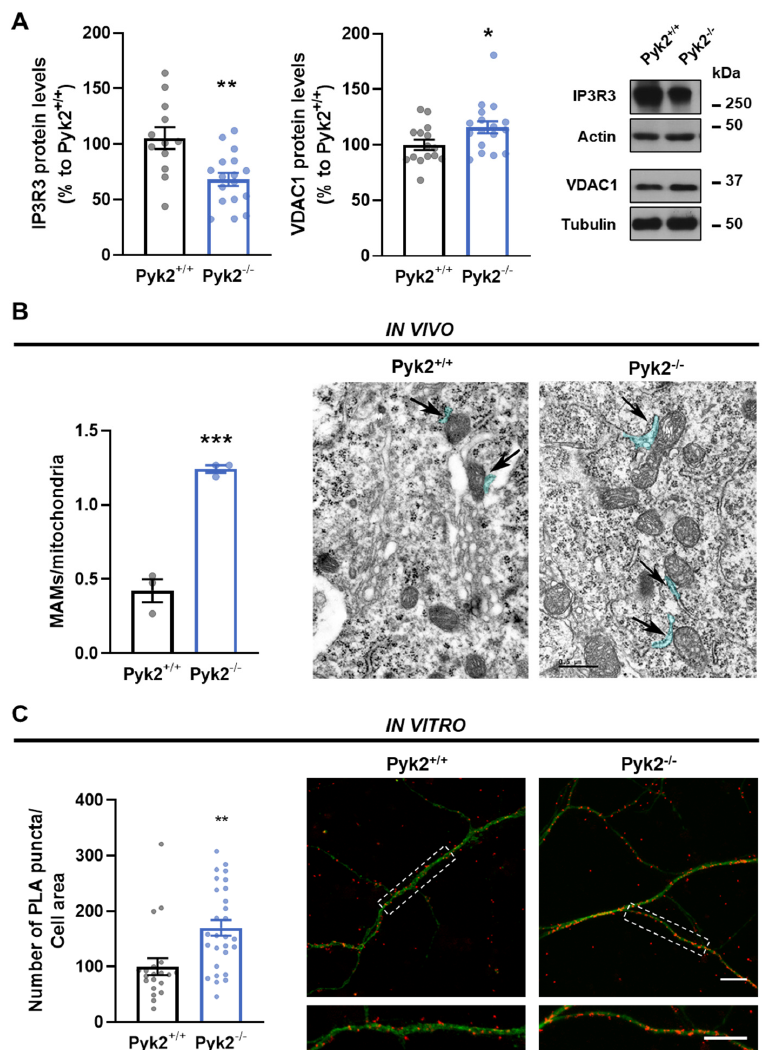
Figure 3. Pyk2 ablation induces increased number of ER–mitochondria contact sites in vivo and in vitro . ( A ) Densitometry quantification and representative immunoblotting of IP3R3 (Student t -test, t = 3.457, df = 27; * p < 0.05) and VDAC1 (Mann–Whitney test, A, B = 189, 339, U = 69; * p < 0.05) in total lysates of hippocampus from Pyk2 +/+ and Pyk2 − / − mice. Actin or tubulin were used as loading control. Molecular weight markers positions are indicated in kDa in the right panel. Each point represents an animal; ( B ) Quantification of MAMs in vivo in hippocampal slices from mice (Student t -test, t = 9.936, df = 4; p < 0.001) and representative images of electron microscopy. Black arrows indicate MAMs and blue area delineate the analysed region. Scale bar, 0.5 µ m; ( C ) MAMs were quantified in vitro by proximity ligation assay measuring VDAC1-IP3R3 interaction in neurites of hippocampal primary neurons. In ( C ) left panel, quantification shows more MAMs (Student t -test, t = 3.307, df = 46; p < 0.01) in Pyk2 − / − primary neurons. In ( C ) right panel, representative confocal images with interactions between the two targeted proteins in red and anti-MAP2 in green. Scale bar, 10 microns. Data are means ± SEM. Student t -test p values are: ** p < 0.01, *** p < 0.001 vs. Pyk2 +/+ . In ( A ), n = 12–19 animals/group; in ( B ), 50 mitochondria of 6 neurons, from 3 different animals.; in ( C ), n = 20–28 neurons/group from 4 different